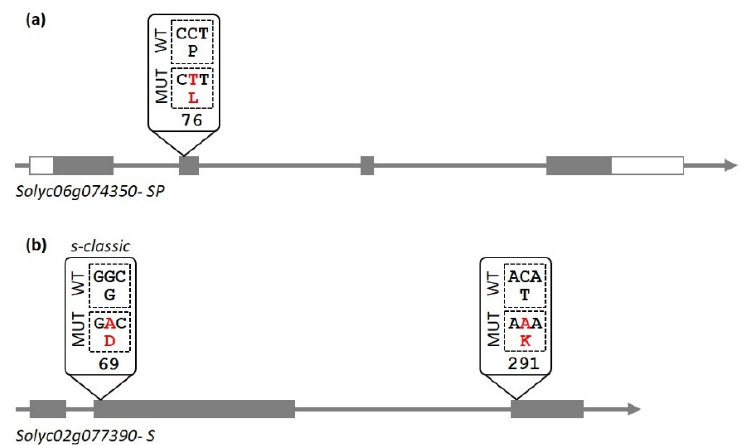
Figure 1. Schematic representation of the SP and S genes and the missense mutations found in them. ( a ) SP gene where the mutation caused a proline (P) into a leucine (L) amino acid change. ( b ) S gene showing the s -classic mutation where a glycine (G) changed into an aspartic acid (D) and a second mutation consisting in a threonine (T) into lysine (K) amino acid change. The numbers indicate the aminoacidic positions inside the proteins affected by the mutations. White boxes, untranslated regions (UTRs); grey boxes, exons; red font, nucleotide changes found in the mutant alleles. WT, wild type; MUT, mutant.